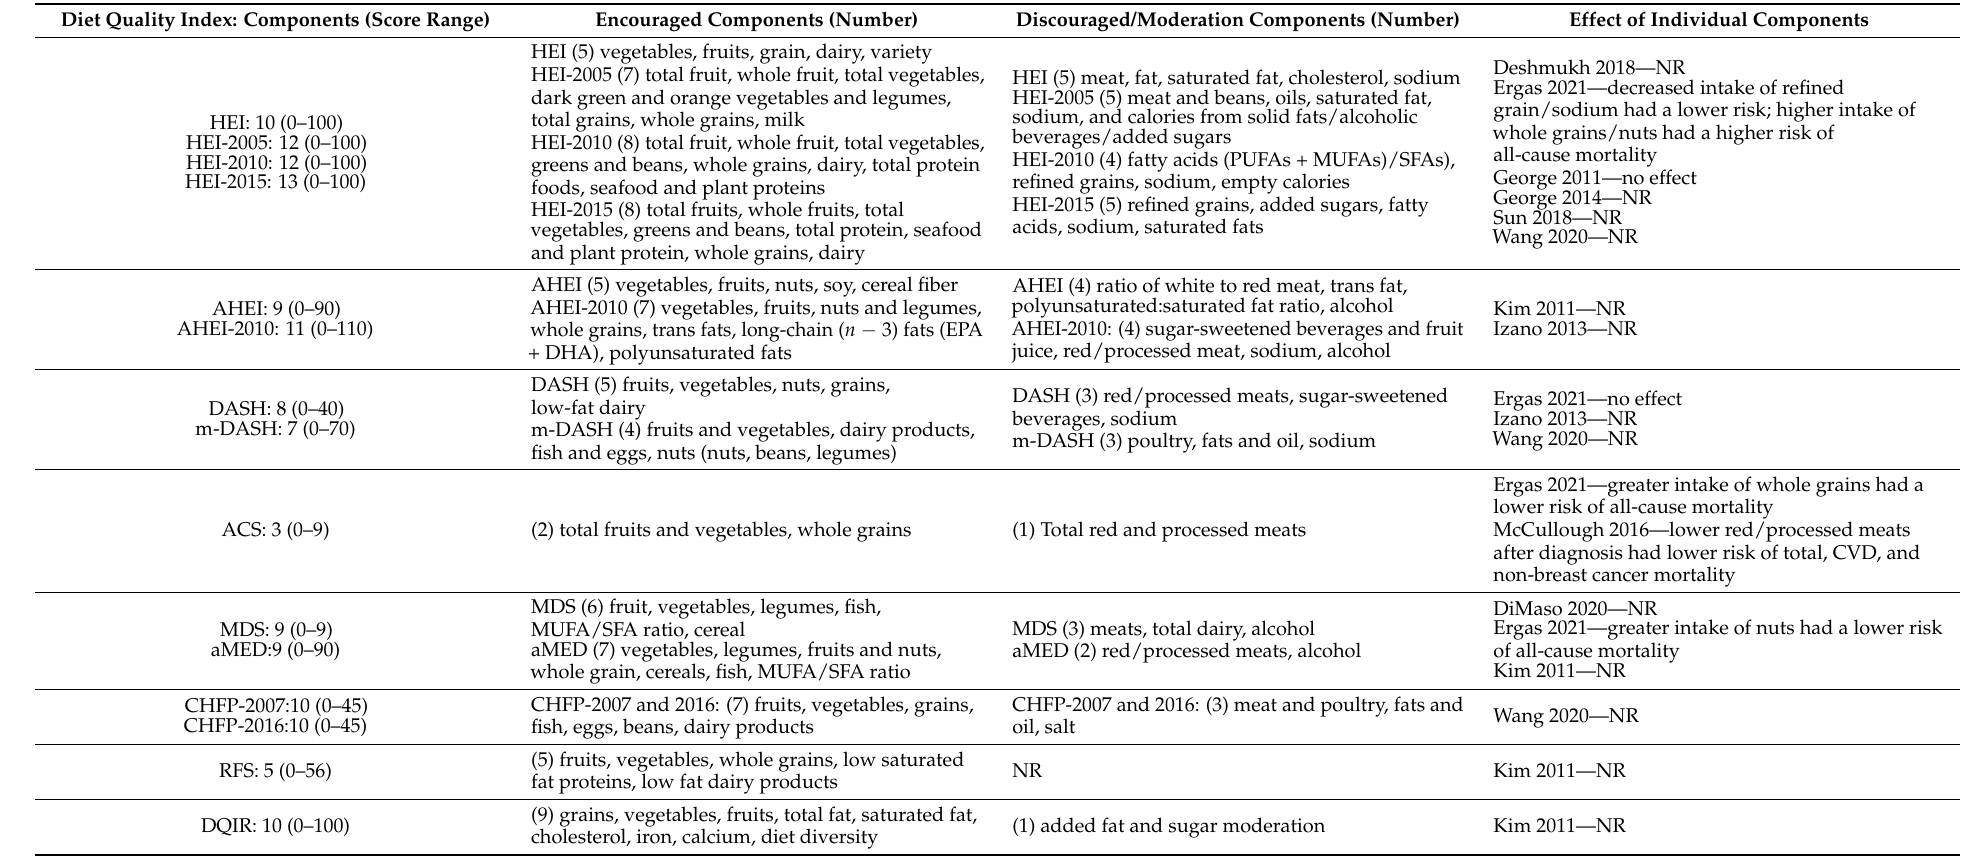
Table 3. Comparison of dietary quality indices included in the systematic